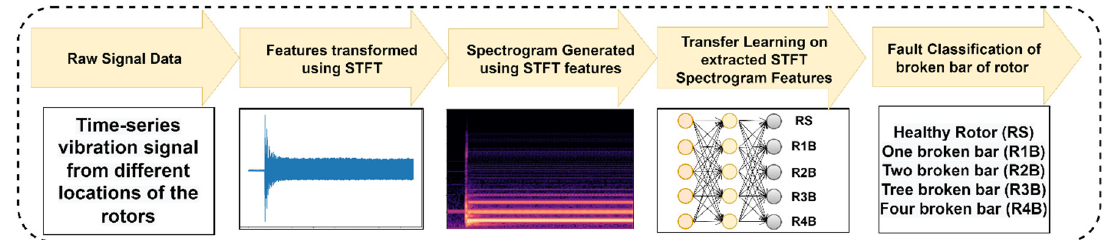
Figure 8. Working procedure of the proposed work using time-frequency domain (STFT) analysis.